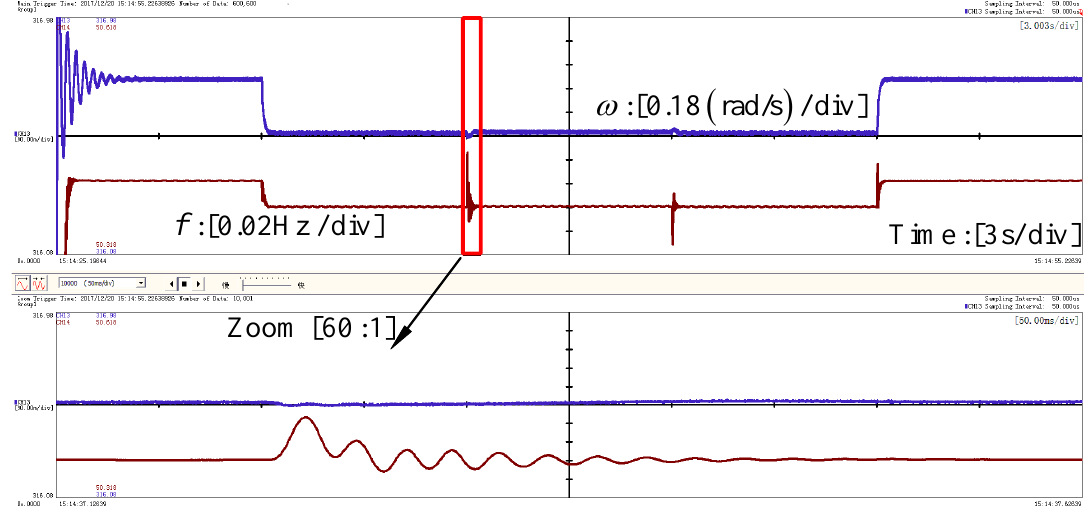
Figure 15. Experiment results of the system frequency: the frequency f from extra PLL circuit; and the angular frequency reference ω .